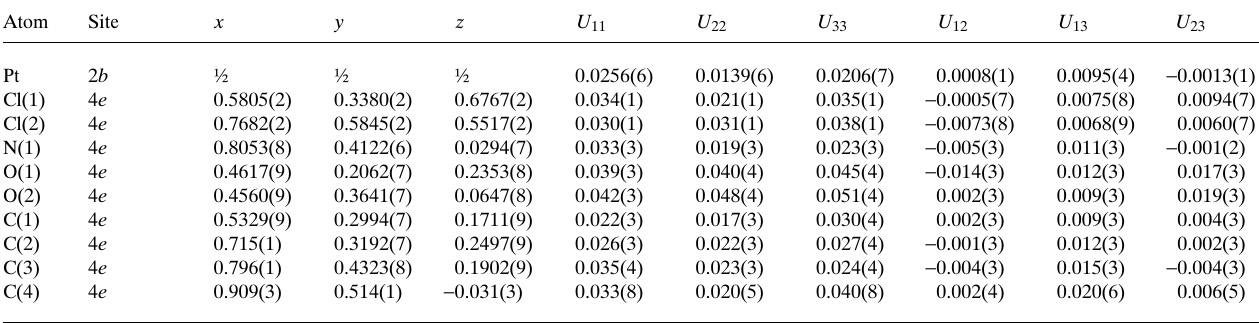
Table 3. Atomic coordinates and displacement parameters (in Å 2 )